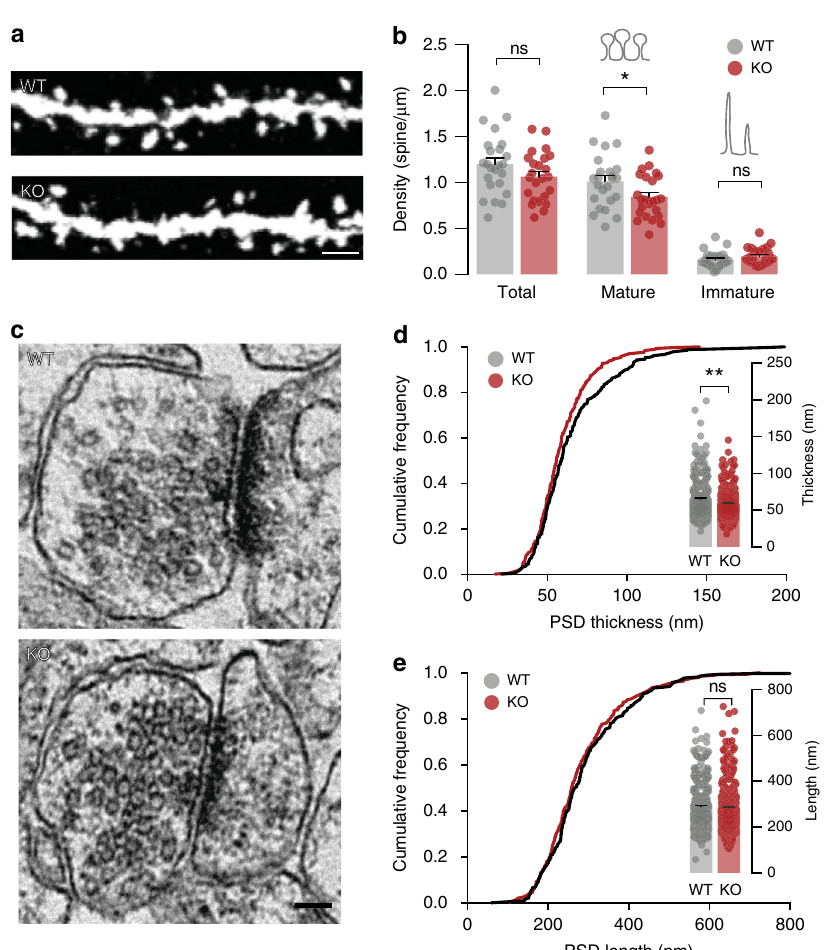
Fig. 3 Impaired spine maturation in hippocampal spines in Gprasp2 KO mice. a Representative images from secondary dendrites of CA1 hippocampal neurons from Gprasp2 − /y mice and WT controls. Scale bar 1 µ m. b Reduced density of mature spines in secondary apical branches of hippocampal CA1 neurons from Gprasp2 − /y mice; WT n = 24/3 branches/mice, KO n = 24/3 branches/mice; two-tailed t -test. c Representative electron micrographs from hippocampal PSDs from Gprasp2 − /y and WT mice. Scale bar, 100 nm. d , e Gprasp2 − /y mice present thinner PSDs ( d ) but no signi fi cant alterations in PSD length ( e ) when compared with WT animals; WT n = 337/3 PSDs/mice; KO n = 362/3 PSDs/mice, two-tailed Mann – Whitney test. Data in ( d ) and ( e ) (main graph) are presented as a cumulative frequency plot, all other data are presented as means±s.e.m. Statistical signi fi cance: * p <0.05, ** p